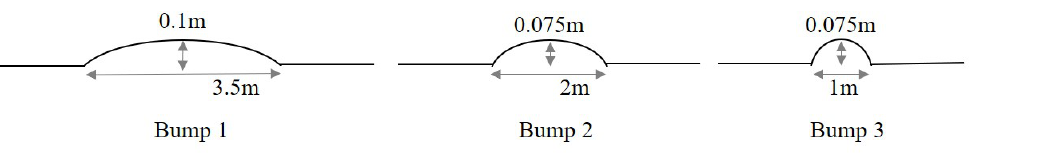
Figure 6. ( a ) flat road: flat, asphalt road; ( b ) sinusoidal road: sine wave road (amplitude: 0.05 m, wavelength: 10 m); ( c ) manhole and pothole: road with many manholes and potholes; ( d ) bump: bumps on the flat road. Three different types of bumps are used as shown in Figure 7.